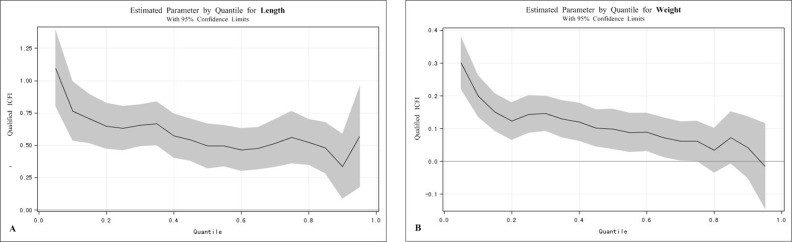
(A) This figure clearly indicates that regression coefficients varied by quantiles of children’s height after controlling for confounding factors. (B) This figure clearly indicates that regression coefficients varied by quantiles of children’s weight after controlling for confounding factors.